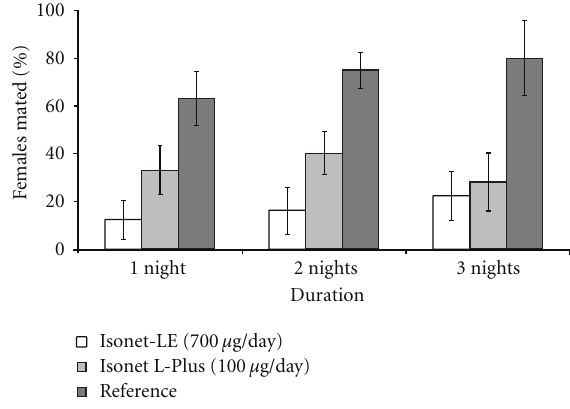
Figure 3: E ff ect of the duration of insect exposure on the percentage of E. ambiguella females mated in field cages (mesh size = 1500 µ m, containing no pheromone dispenser). The notation µ g/day repre- sents the approximate daily emission rate of pheromone dispensers for E. ambiguella ; data are untransformed; bars = 1 SE.